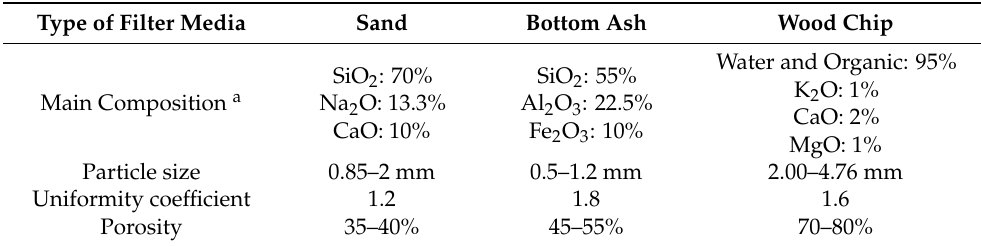
Table 1. Physical and chemical properties for sand, bottom ash, and wood chip.